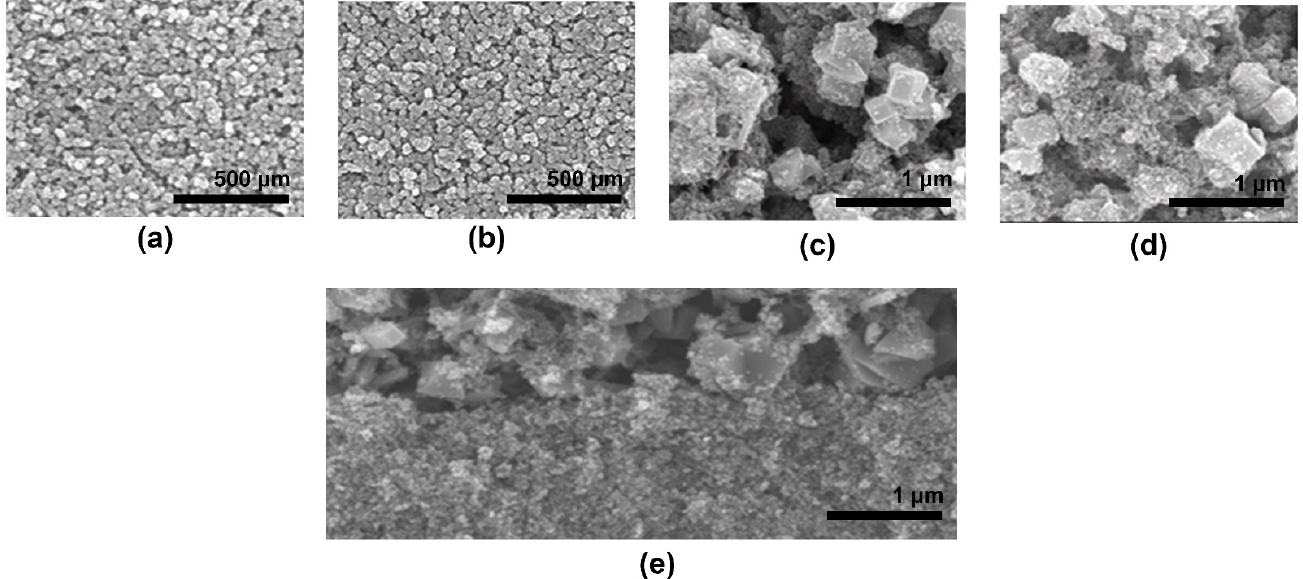
Figure 5. SEM images of the top view of TiO 2 electrode without ( a , c ) and with ( b , d ) TiCl 4(aq) post-treatment. ( e ) The cross-section of meso-TiO 2 electrode on FTO glass.